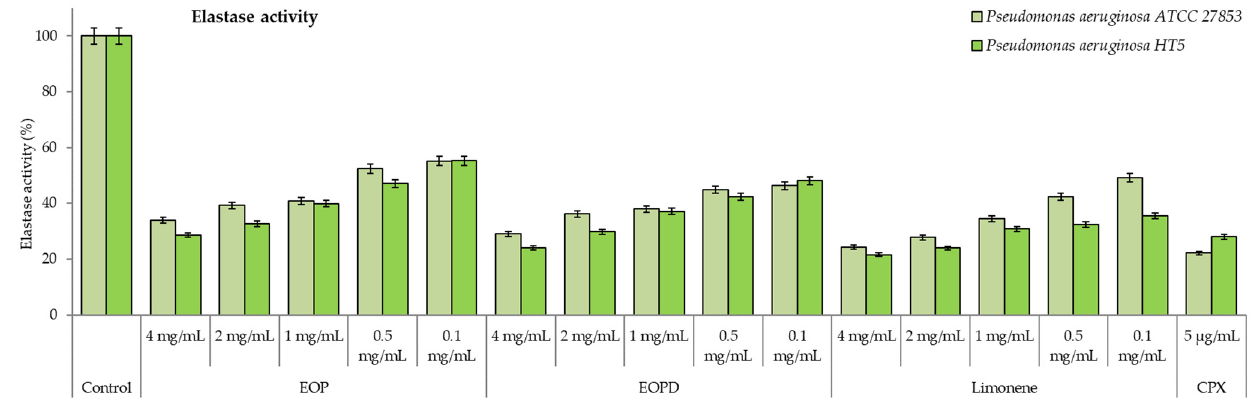
Figure 6. Elastase activity of Pseudomonas aeruginosa ATCC 27853 and HT5 strains. EOP: Essential oil obtained by cold-pressed method; EOPD: essential oil obtained by cold-pressed method followed by steam distillation; L: limonene; CPX: ciprofloxacin. Data are presented as means ± SEMs ( n = 8) of three independent experiments. All experiments show significant differences compared to respective controls ( p < 0.05).